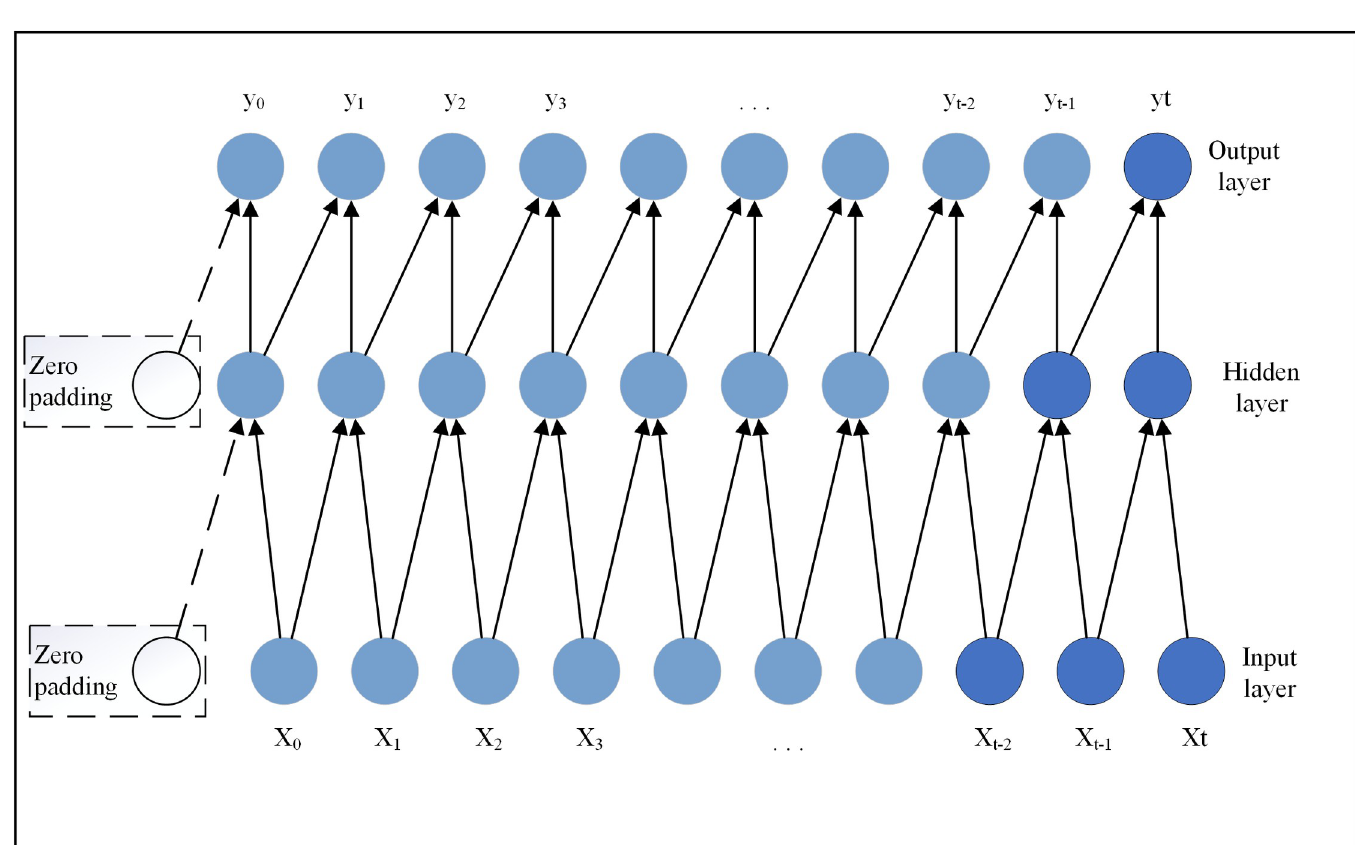
Fig 2. Causal convolution